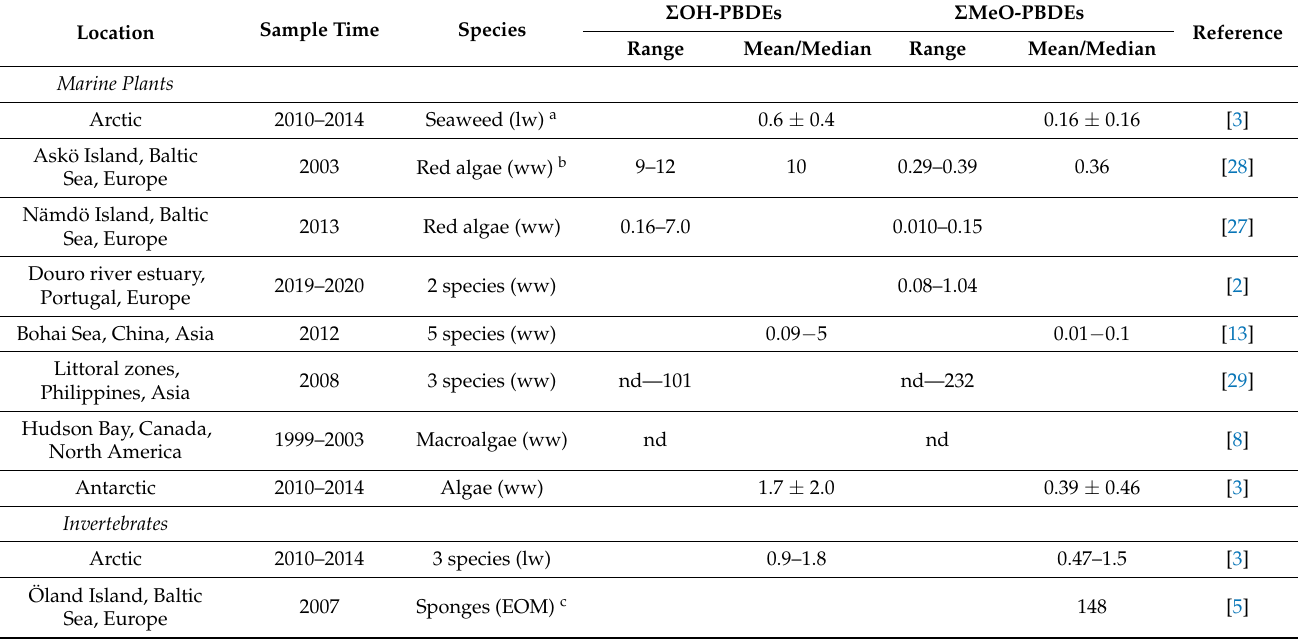
Table 3. Concentrations of OH/MeO-PBDEs in marine biotas